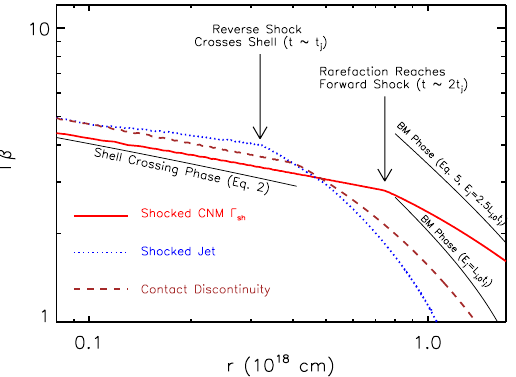
Figure 1. Schematic illustration of the forward-reverse shock structure produced by the interaction of a relativistic jet and the surrounding circumnuclear medium during the early phase ( t (cid:1) t j ) when the reverse shock crosses back through the shell of ejecta released during the initial period of jet activity (from MGM12).